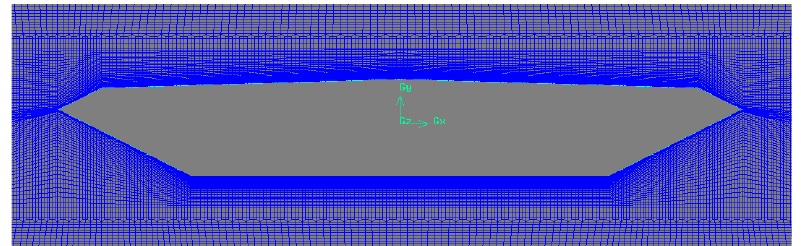
Figure 4. Mesh near the GBEB girder section model.